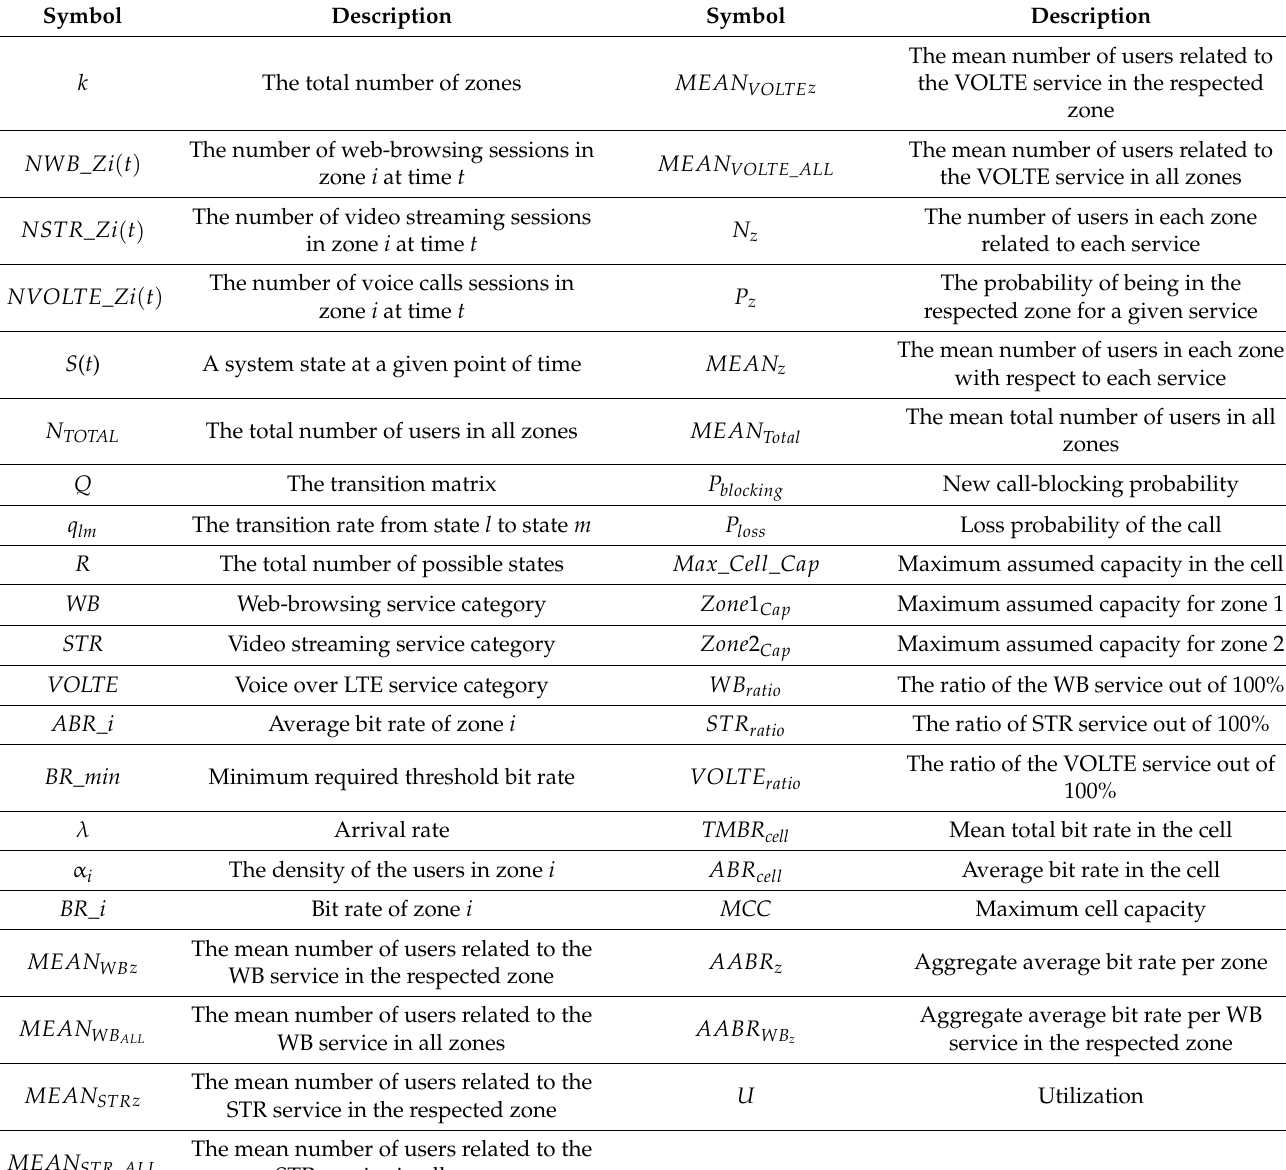
Table 1. Symbols used in the mathematical formulation of the